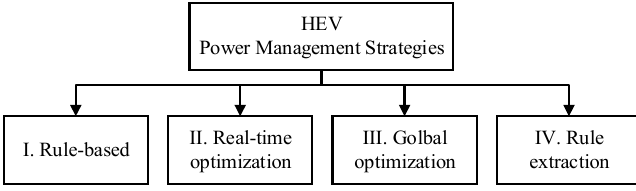
Figure 1. Classification of power management strategies.